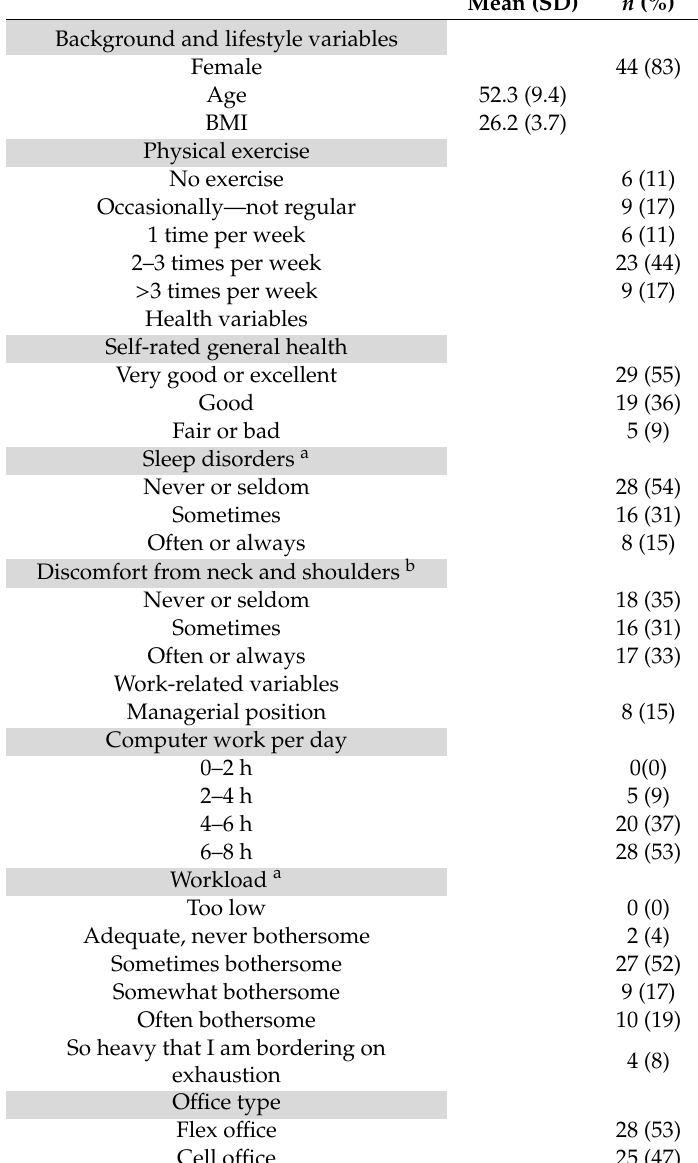
Table 1. Characteristics of participants, n =